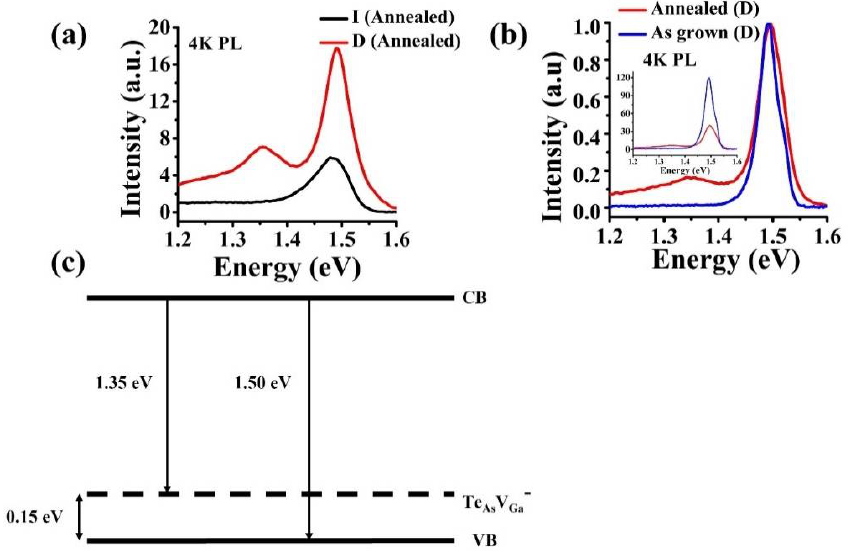
Figure 3. ( a ) 4K PL spectra of annealed intrinsic and Te-doped GaAs using a GaTe source temperature of 550 °C, ( b ) comparison of unnormalized and normalized 4K PL of as-grown and annealed doped NWs, respectively, and ( c ) band diagram of n-GaAs NWs.